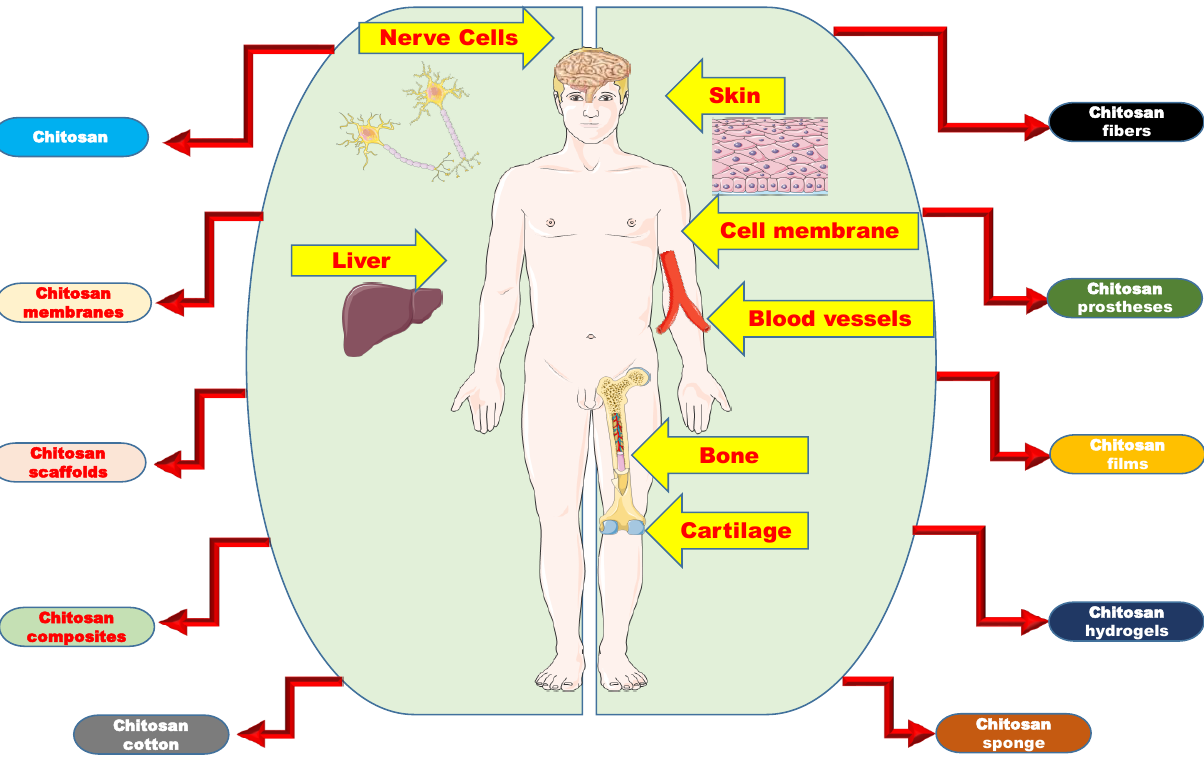
Figure 1. Overview of the organs to which chitosan and its composites have contributed to and the various chitosan forms that have gone into the making of the artificial organs.